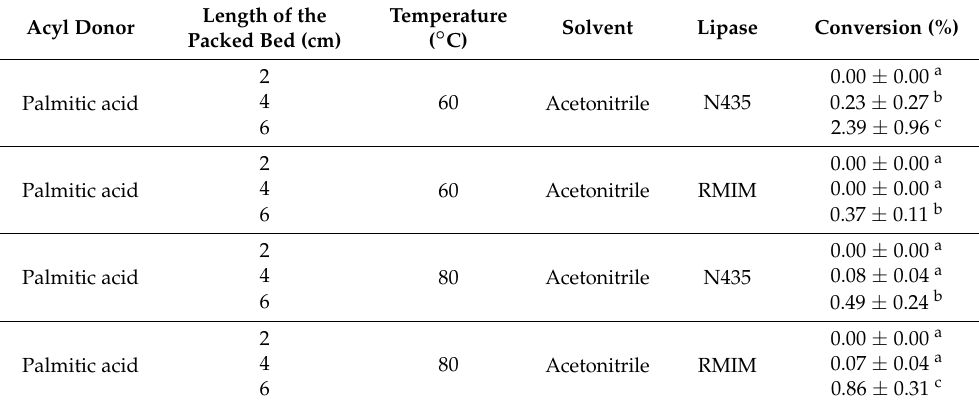
Figure 5. The experimental data of solvent-free 7- O -kojic acid monopalmitate (7- O -KAP) synthesis in fluidized tank reactor (FTR) at 70 °C, 5% enzyme loading for 240 min using Novozyme 435 (N435) and RMIM. Data are presented as means ± S.E.M, n = 3. The letter a indicates significant difference at p < 0.05 with Bonferroni’s Multiple Comparison Test. Table 1. The yield of 7- O -KAP synthesized by enzymatic esterification using immobilized lipase (N435 and RMIM) in a continuous packed bed reactor. The substrate molar ratio used for this experiment was 1:1. The letters a, b, and c indicate significant difference at p < 0.05 with Bonferroni’s Multiple Comparison Test.